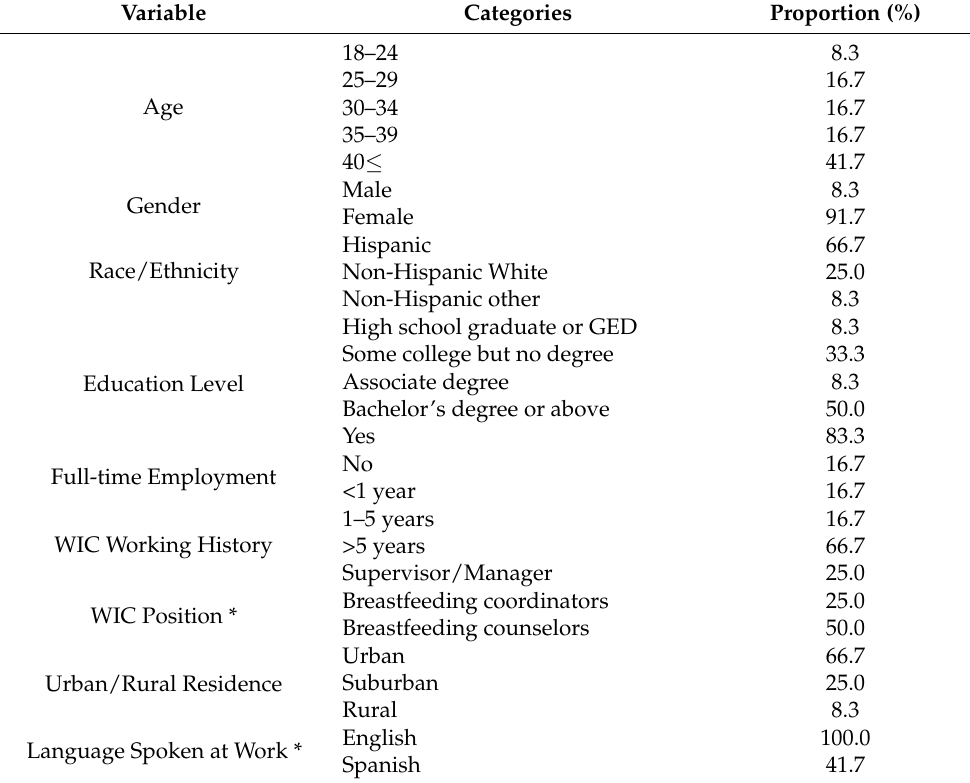
Table 2. Characteristics of WIC Staff Interviewed (n =